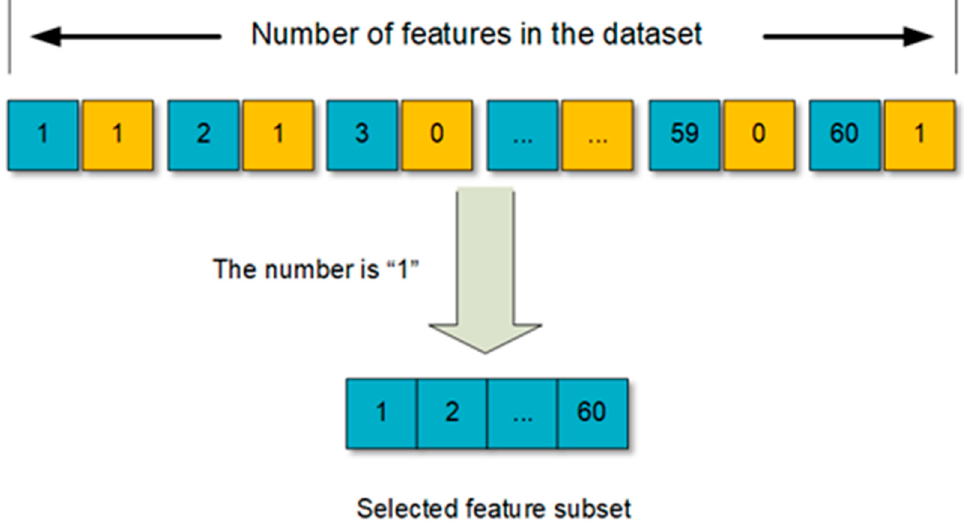
Figure 5. Selecting a feature subset from the total features.